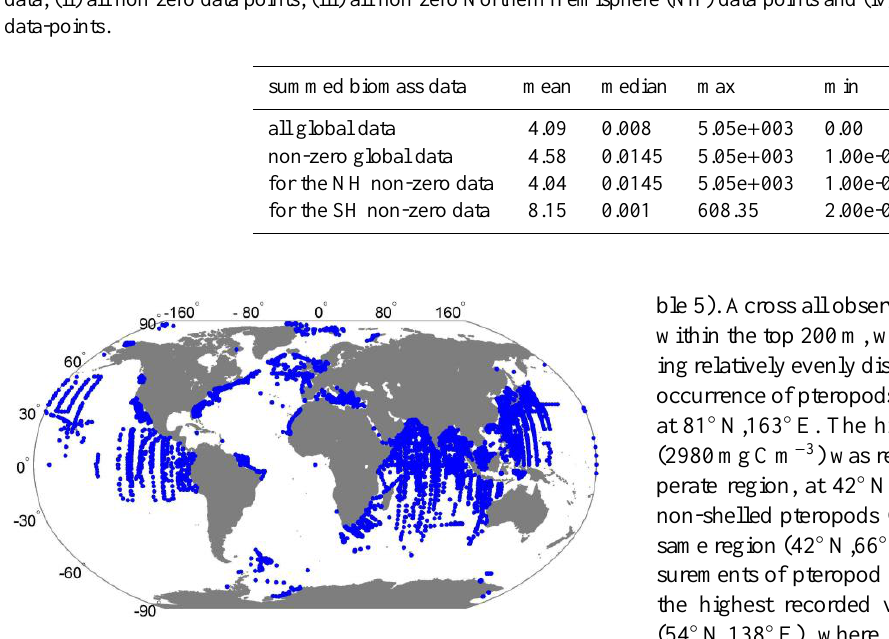
Figure 4. Global distribution of quality-controlled pteropod